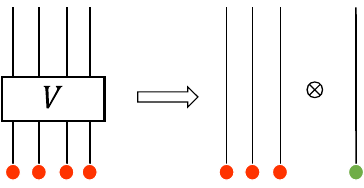
FIG. 1. We disentangle the green qubit from others by a local unitary transformation V and then remove this part. This is called a generalized local unitary